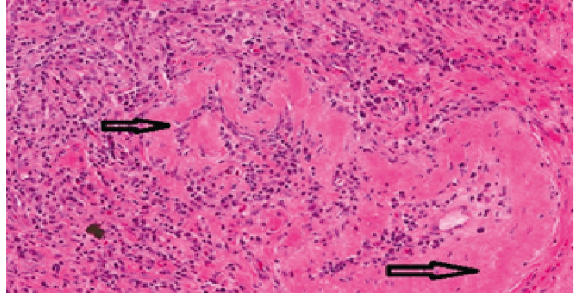
Figure 4: High power field showing obliterative phlebitis with destruction of the vessel